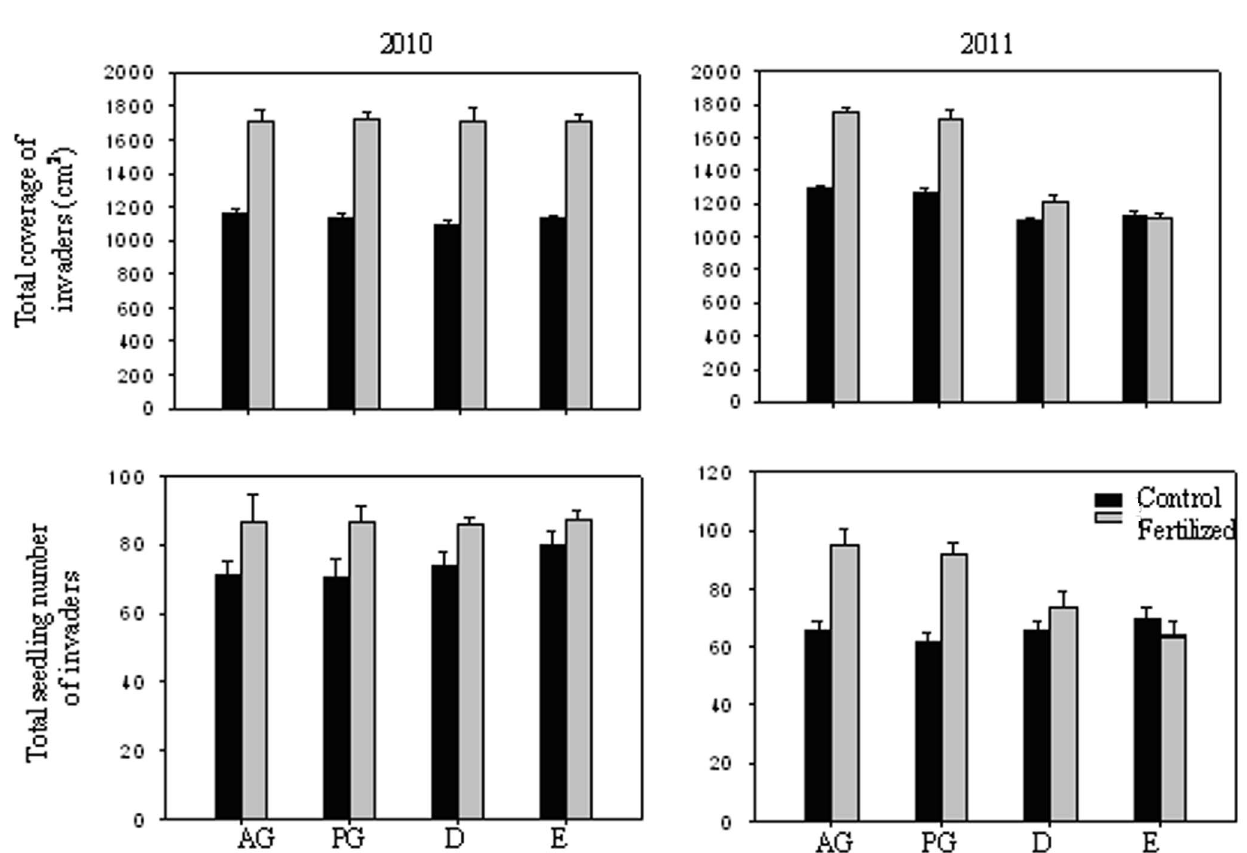
Figure 1. Effects of dominant functional group and fertilization on the coverage and seedling number of total invaders in 2010 and 2011. Dominant functional group treatments: AG – annual grass dominated pots. PG – perennial grass dominated pots, D – deciduous shrub or arbor dominated pots and E – evergreen shrub or arbor dominated pots.